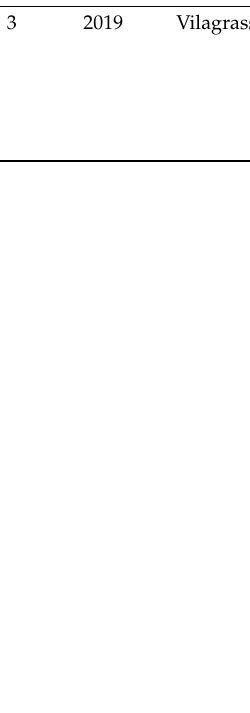
Table 4. Trials of fungicide application strategies against the almond red leaf blotch conducted